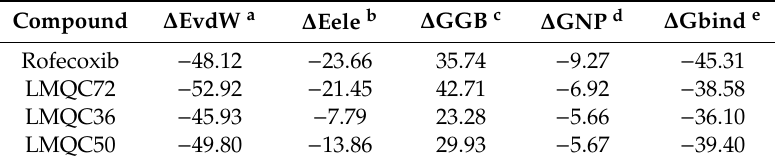
Table 7. Binding free energy h COX-2-ligands.